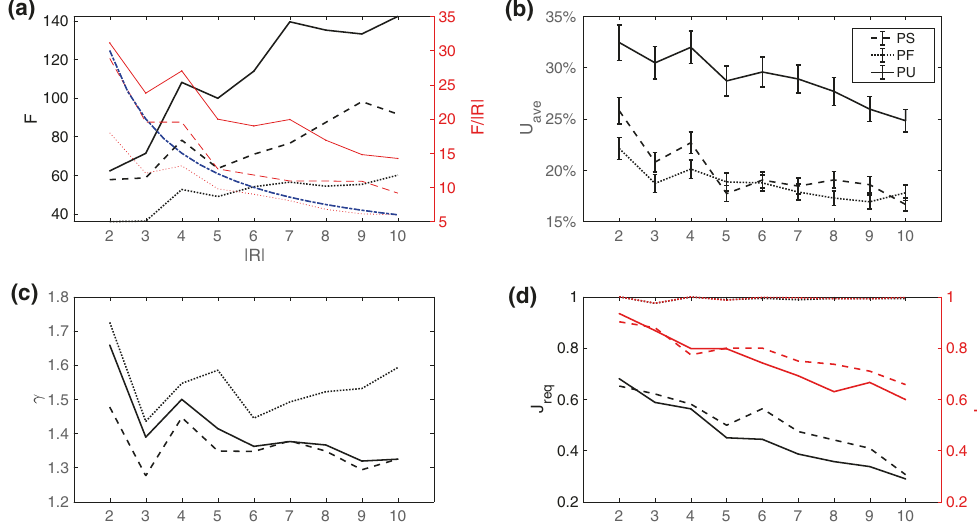
Fig. 8 Performance under different number of requests (2 – 10) per window. a Throughput F and normalized throughput F / ∣ R ∣ ; blue curve shows the reference line 60/ ∣ R ∣ . b Traf fi c mean U ave and variance U var (which is shown as the error bars with reduced scale of factor 2). c Delay γ . d Fairness J req and J path